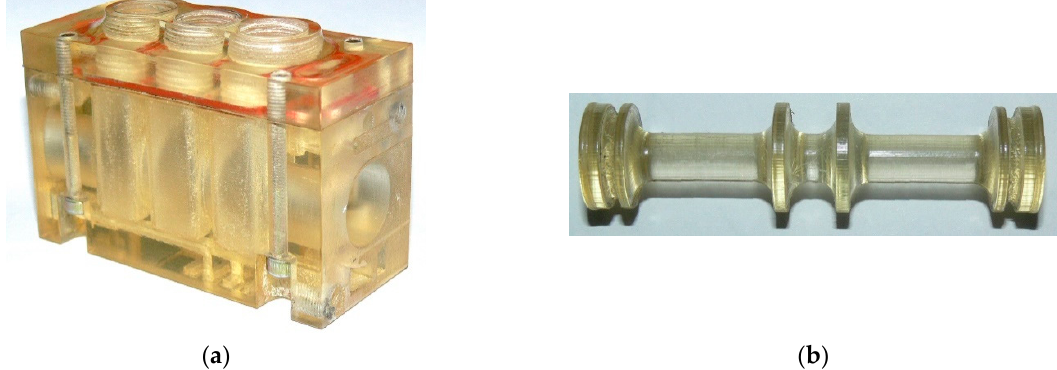
Figure 4. Physical model made using the PolyJet Matrix technology: ( a ) valve body and the subbase, ( b ) spool.